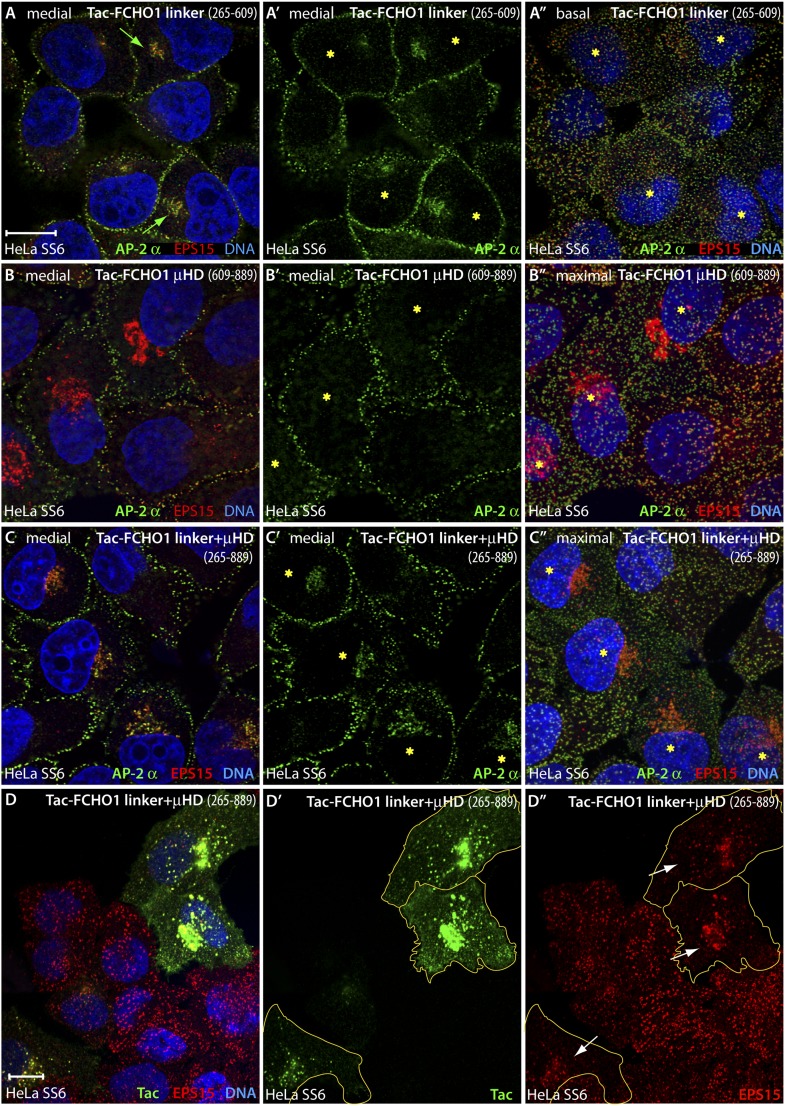
An artificial transmembrane FCHO1 linker protein misrecruits AP-2 onto internal membrane structures.(A–A″) Selected medial (A and A′) or basal (A″) optical sections of deconvolved confocal z-stacks collected from HeLa SS6 cells transiently transfected with Tac-FCHO1 linker (residues 265–609). Fixed cells were stained with anti-AP-2 α subunit mAb AP.6 (green) and affinity purified anti-EPS15 antibodies (red) and mounted in Hoechst 33342 to label DNA (blue) prior to imaging. Aberrant accumulation of AP-2 and EPS15 adjacent to the nucleus (arrows) in Tac-transfected cells (asterisks) correlates with smaller clathrin-coated puncta in the basal optical section of the same cell population (A″). Scale bar (for A–C″): 10 μm. (B–C″) Chosen middle (B, B′, C and C′) or maximal projection (B″ and C″) optical sections of HeLa SS6 cells transfected with Tac-FCHO1 μHD (residues 609–889) or Tac-FCHO1 linker + μHD (residues 265–889) and prepared analogously to (A–A″). The Tac-fused μHD produces dramatic relocalization of EPS15 (B), diminishing this protein in surface AP-2-positive puncta (B″) yet AP-2 does not relocate similarly. With ectopic expression of the FCHO linker + μHD, prominent accumulation of irregular intracellular AP-2 and EPS15 in a juxtanuclear locations again correlates with diminished surface clathrin spots, which are again relatively deficient in EPS15 because of the massive deposition of this endocytic pioneer component upon intracellular membranes. (D–D″) Single ventral optical section of HeLa SS6 cells transfected with Tac-FCHO1 linker + μHD (residues 265–889) and stained with anti-Tac mAb (7 G7B6; green) and affinity-purified anti-EPS15 antibodies (red). Relocalization of EPS15 occurs only in Tac overexpressing cells (arrows), and the dose-dependent massing of EPS15 in the perinuclear region limits the amount of EPS15 present in surface clathrin-coated structures. The limiting membrane of the Tac-expressing cells is delineated (orange). Scale bar: 10 μm.